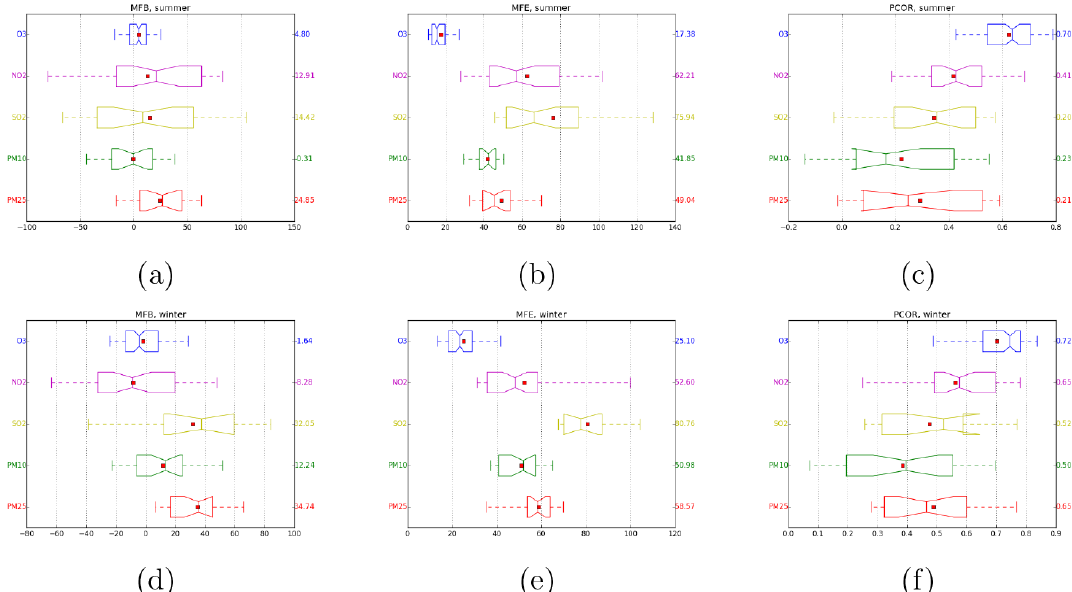
Figure 8. Performance statistics for the main model species and for daily averaged values. The numbers on the right axes give the overall scores (Pearson’s correlation, MFE, and MFB), while the box plots show the variability among the EMEP stations. The boxes extend from the lower- to upper-quartile values of the data. The center lines show the medians, and the red squares show the means over stations. The whiskers indicate the 5 and 95 percentile values, and the values on the right axis of each panel are the overall value of the considered indicator, i.e., merging all the stations into a single statistical dataset as described in Jacobson